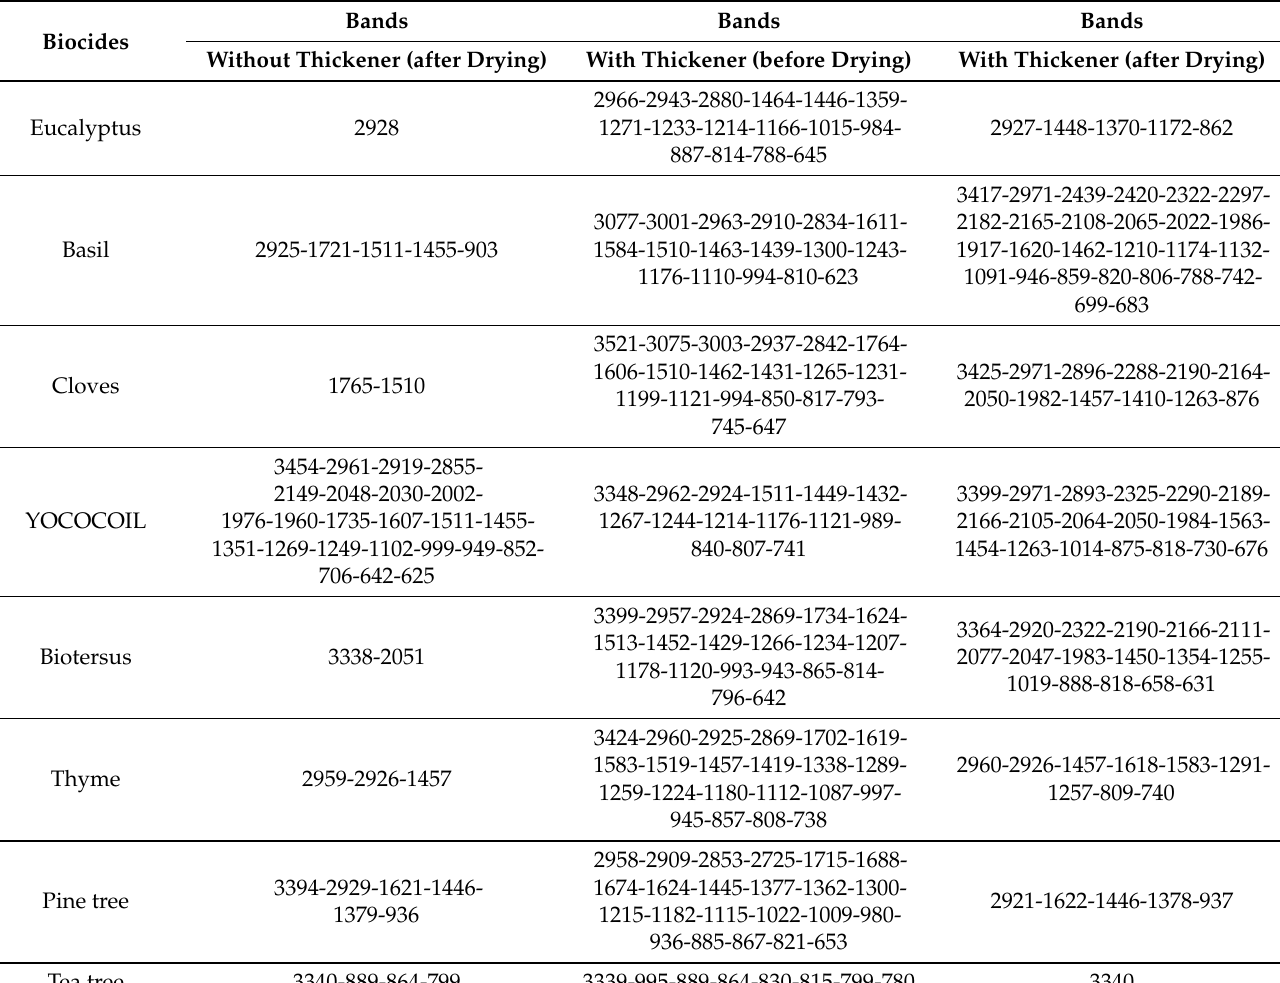
Table 2. FTIR-ATR main peaks related to the tested reagents: as pure compound without thickener (after the evaporation process), as applied products with thickener (before and after drying). The collected peaks related to the thickener NEVEK and to the glass specimen were removed from each measure present in the